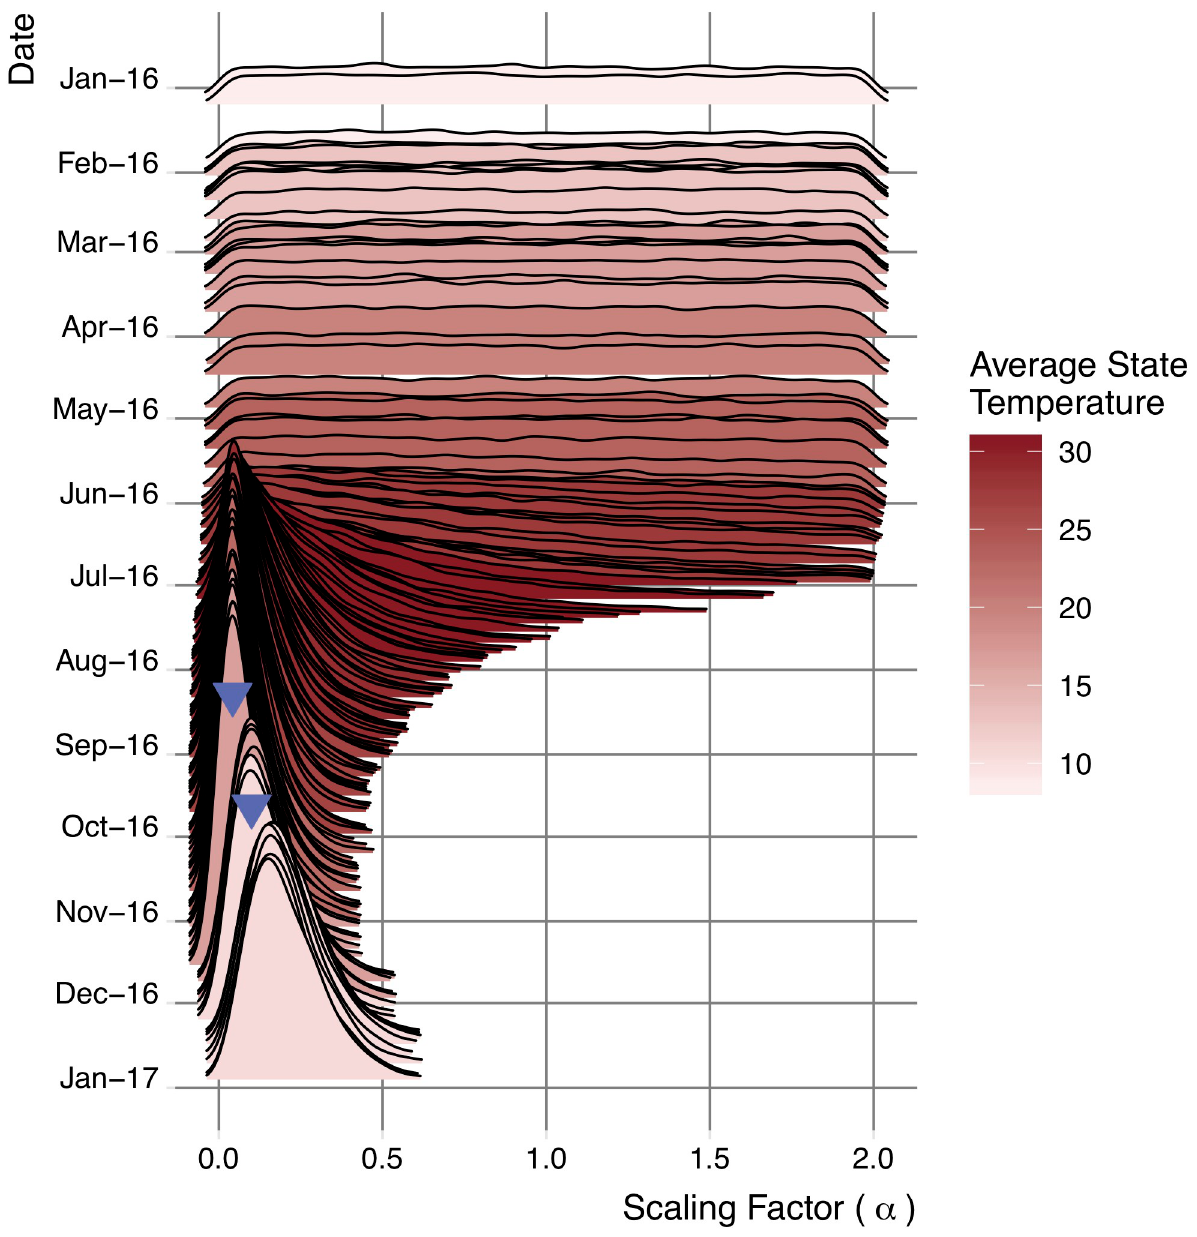
Fig 3. Evolving posterior distribution of statewide scaling factor for R 0 . Zika importations, both with and without subsequent detected autochthonous transmission, provide insight into local transmission potential, via a statewide scaling factor, α . This shows the posterior distributions of α , for each day of 2016 that had at least one imported case. Median estimates reach a minimum in early November, just before the detected autochthonous transmission events (upside-down blue triangles). Red shading indicates the average statewide monthly temperature. Note: the scaling factor is never less than